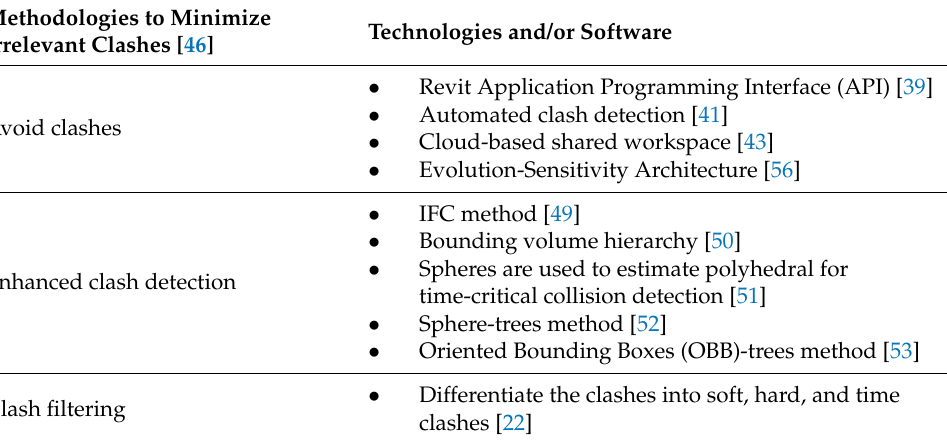
Table 1. A summary of technologies and/or software that could help to minimize irrelevant